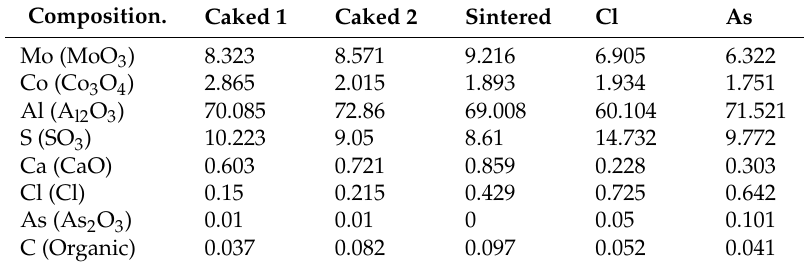
Table 3. Elemental distributions of di ff erent CATs deactivated by other reasons, the standard deviation of the measured value is set as unity in the last